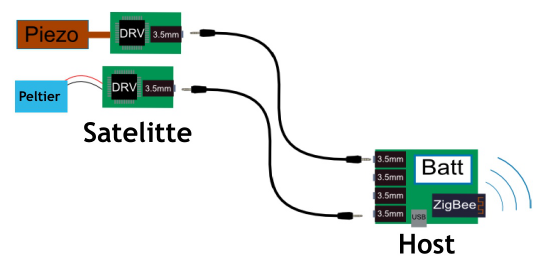
Figure 2. The host system communicates with the user’s tablet via ZigBee. Satellites are connected